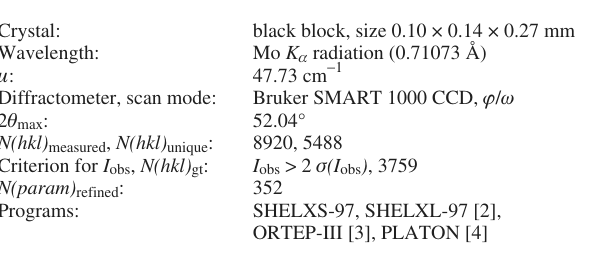
Table 1. Data collection and handling.